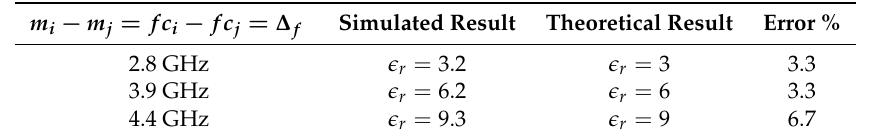
Table 3. Simulation measures (in frequency domain) obtained in three different materials. Cutoff frequency differences are obtained in waveguide transmission (shown in Figure 7). Theoretical and simulated measures are compared.